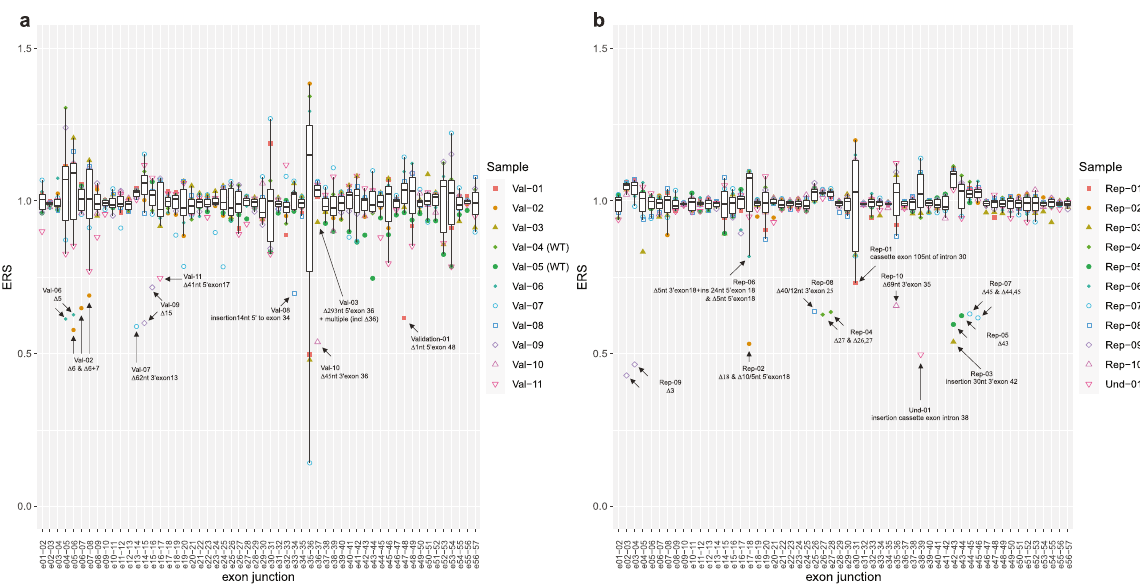
Fig. 1 Drop in enrichment score of normal exon splice junctions for all NF1 patients is clearly visible in close proximity to their speci fi c pathogenic splicing event. Enrichment score of normal exon-exon splice junctions of the validation cohort ( a ) and the replication cohort ( b ). Shown are the ERS score for the normal exon splice junctions for the validation ( a ) and replication ( b ) cohort. Annotated in the fi gures are the drop in ERS due to the pathogenic splicing event. Normal reference exon splice junctions are expected to have a median ERS ~1. center line of the boxplot represents the median value (Q2), bounds of box are Q1 and Q3 respectively and whiskers Q1 – 1.5xIQR and Q3 + 1.5xIQR respectively. Outliers are depicted with color and shape matching the speci fi c sample (see inner fi gure